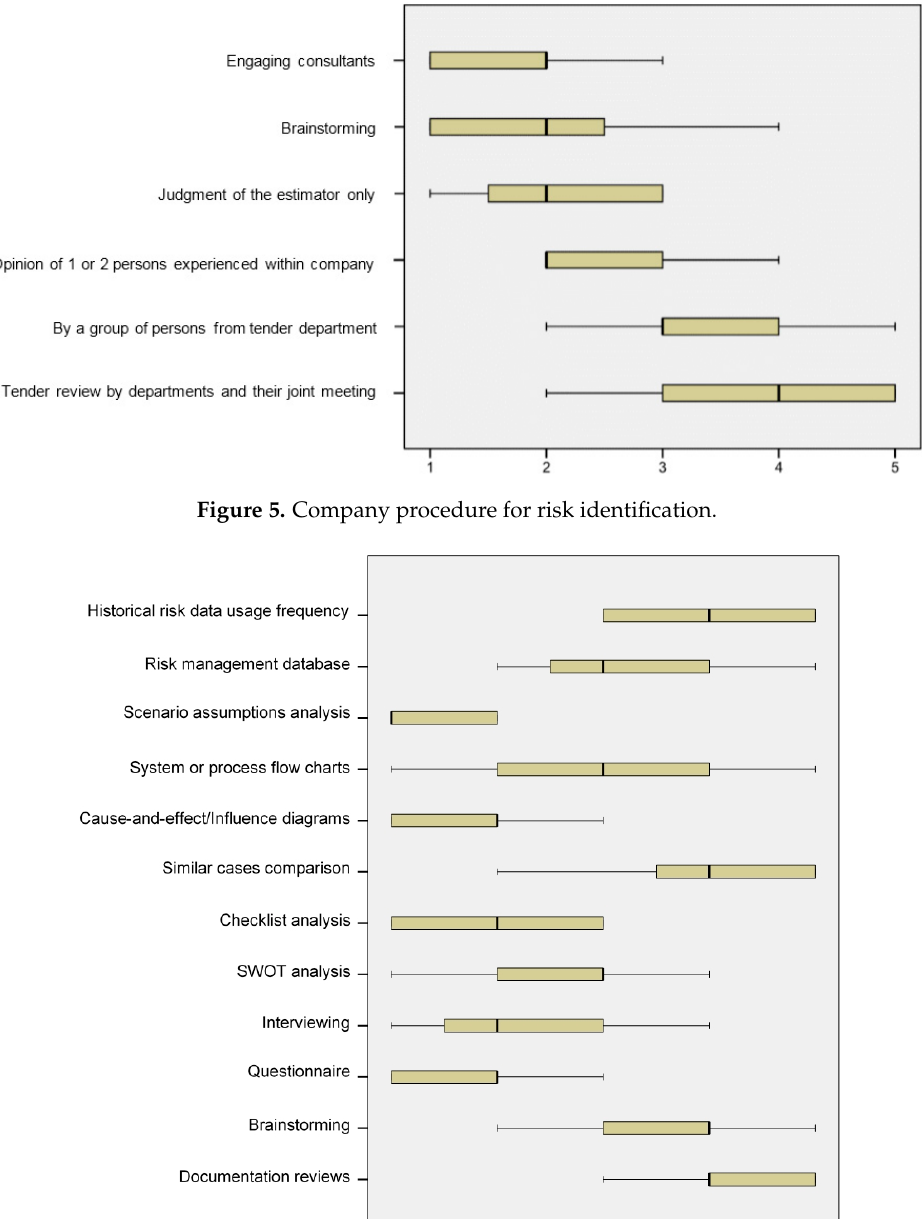
Table 6. Risk identification tools used by the companies.